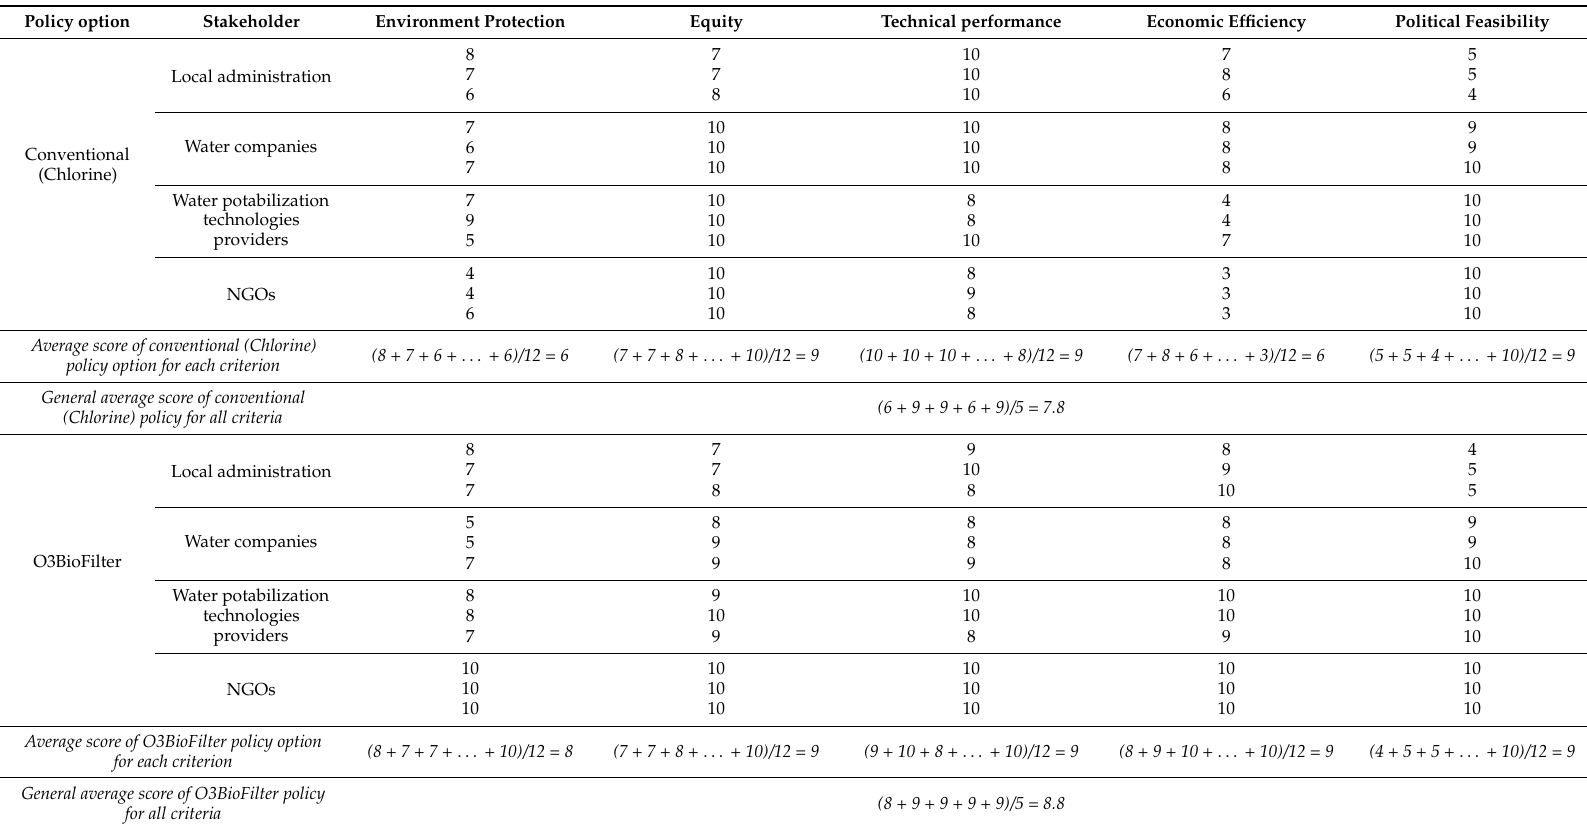
Table 4. Performance level for each criterion and policy option assigned by the representatives of